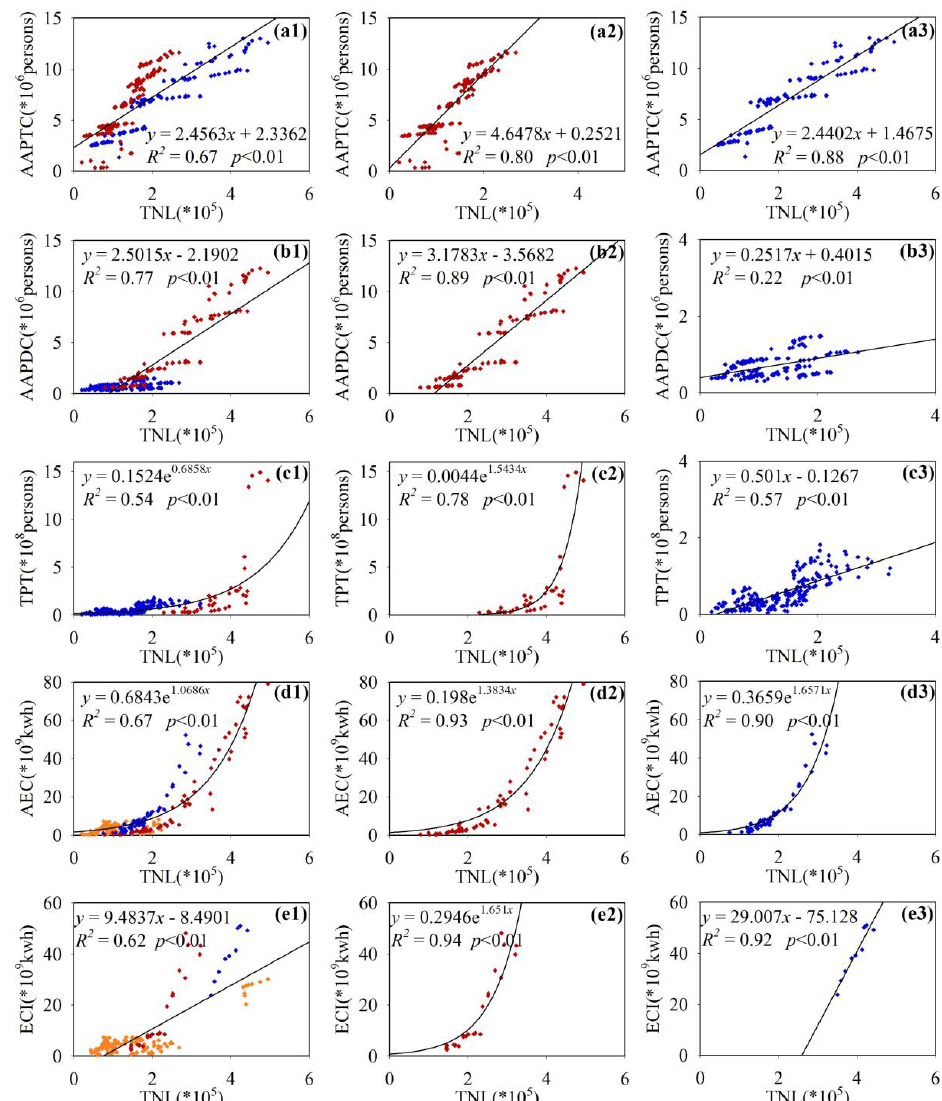
Figure 7. Regression analysis of socioeconomic parameters and TNL at different city levels.